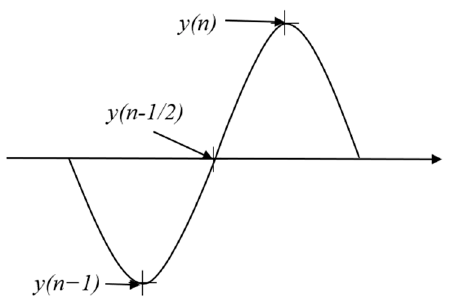
Figure 2. Timing error detection schematic of Gardner algorithm.